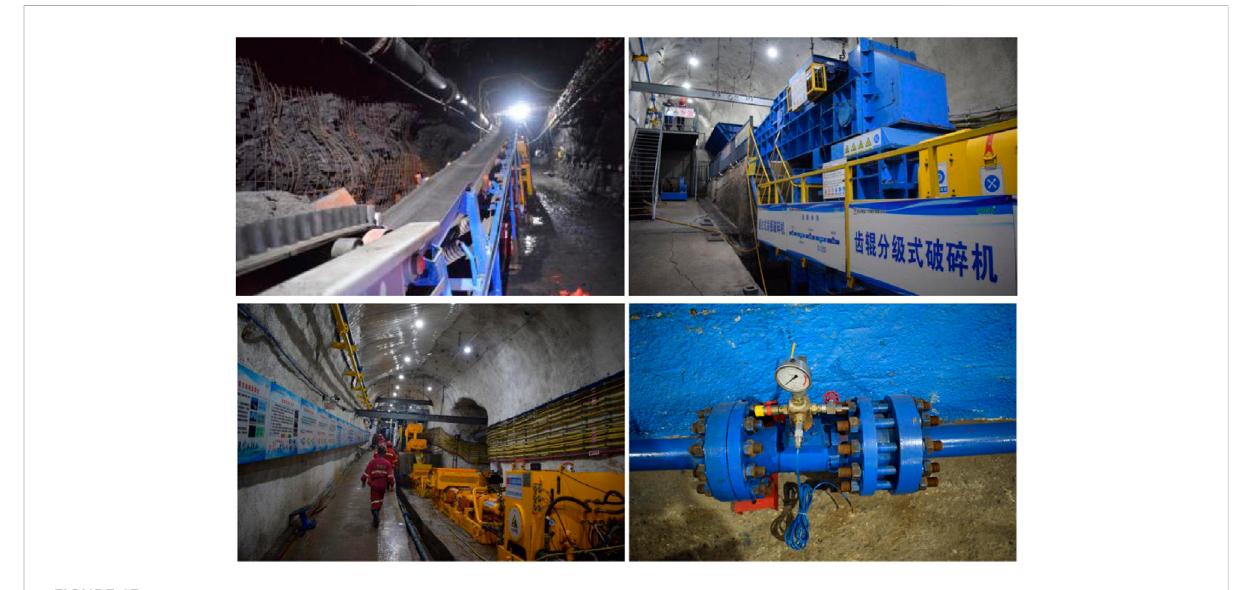
FIGURE 13 Actual picture of fi lling